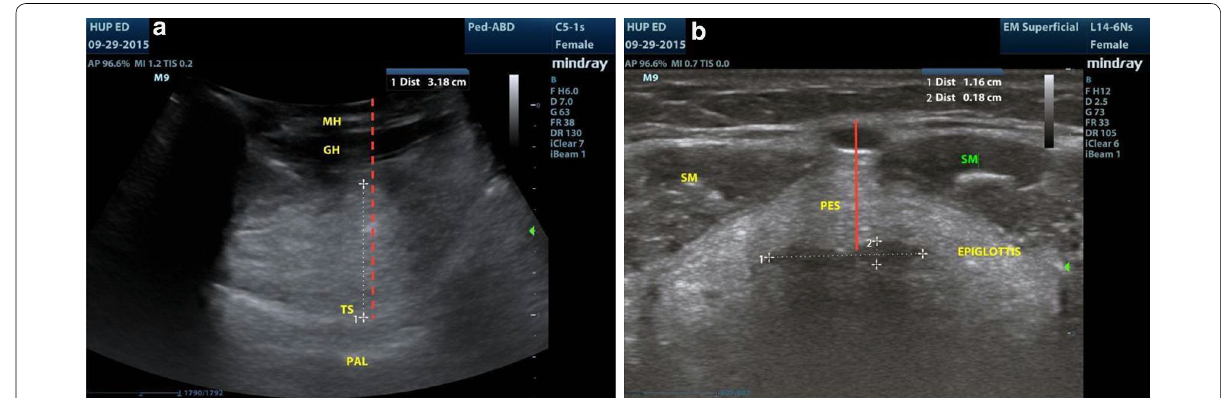
Fig. 1 a Sagittal paramedian view of the tongue from the submental area with the white dotted line representing the tongue base measurement and the red dotted line as tongue base-to-skin thickness. The patient’s face would be in the direction of the right of the screen. MH mylohyoid mus- cle, GH geniohyoid muscle, TS tongue surface, PAL palette. b Transverse ultrasound image at the level of the thyrohyoid membrane. The pre-epiglot- tic space (red line, PES) is measured from the anterior surface of the epiglottis to the anterior margin of the strap muscles (SM) midway between the hyoid bone and the thyroid cartilage. The epiglottis is indicated by the two white caliper lines showing width (dotted line #1) and thickness (dotted line